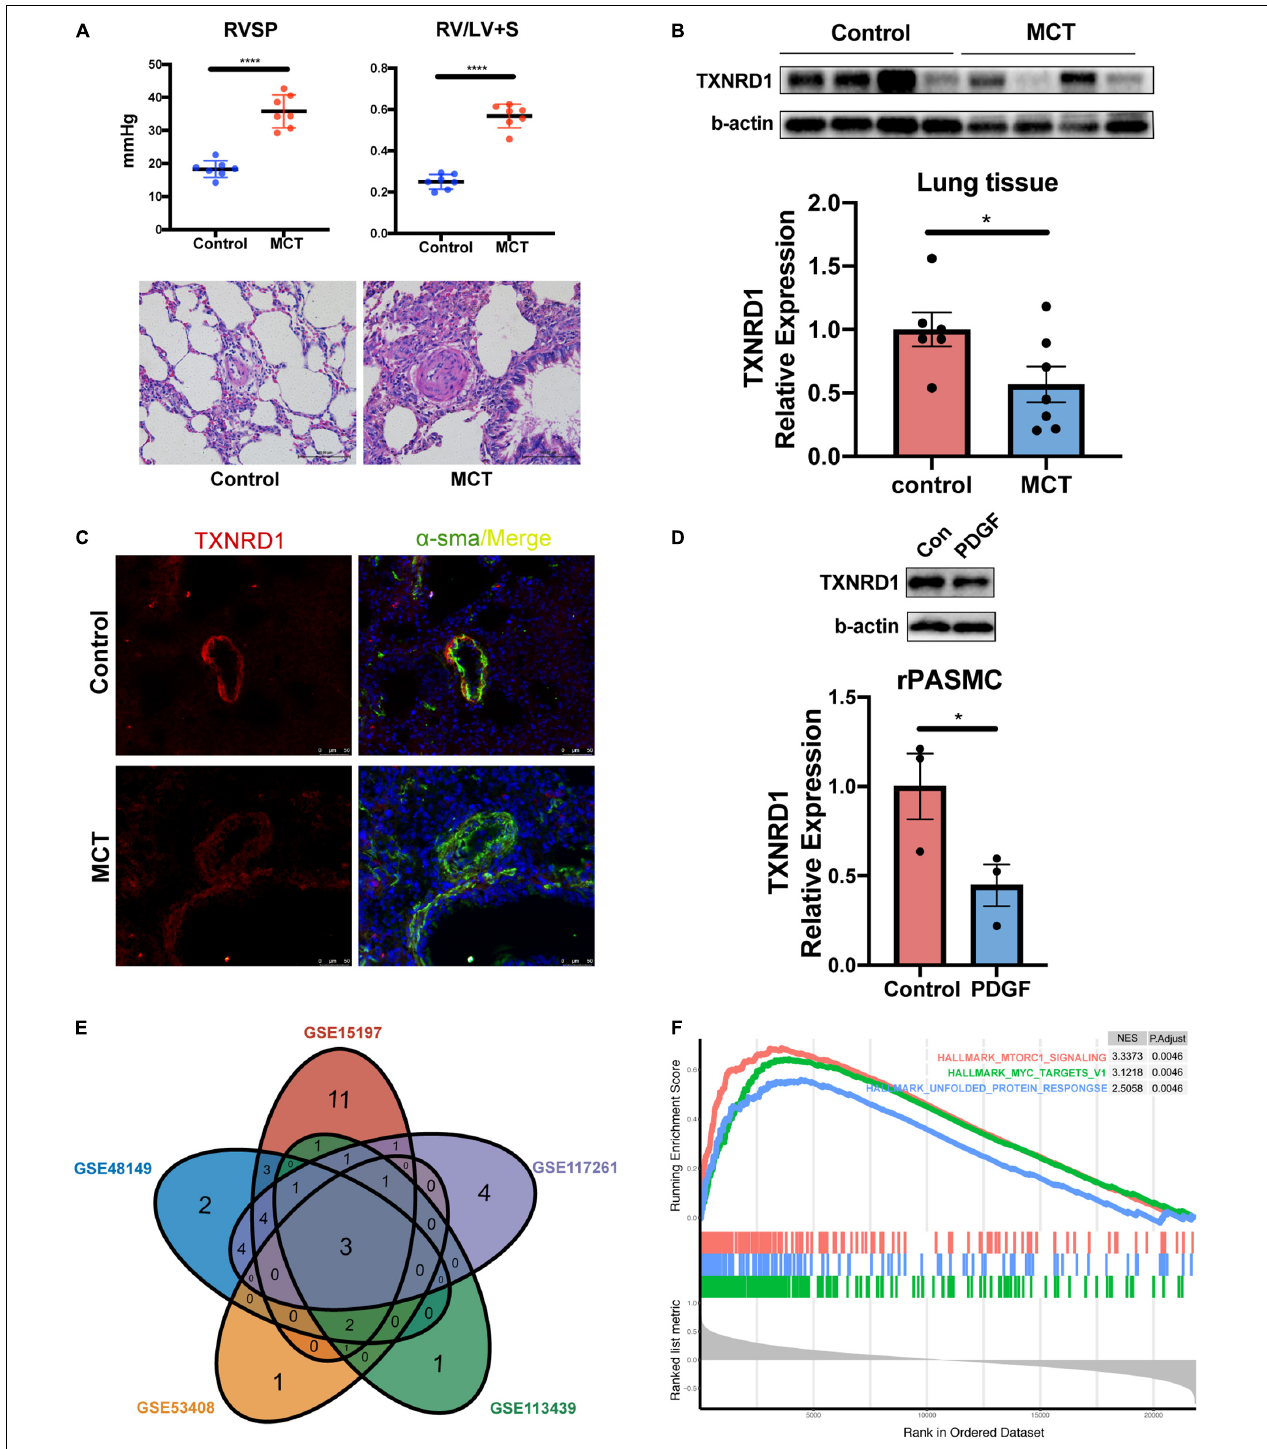
FIGURE 6 | In vitro and in vivo experimental validation and GSEA analysis of TXNRD1. (A) The hemodynamic data and HE staining of lung tissue in animal experiments. (B) Representative Western blots and quantification of TXNRD1 and β -actin in the lungs of monocrotaline treated rats and controls ( n = 7 each, * P < 0.05), data represent the mean ± SEM and Student t -test was used to compare two groups. (C) Immunofluorescence images of lung distal PA from MCT rats and controls. (D) Representative Western blots and quantification of TXNRD1 levels in rat PASMCs under PDGF-BB stimulation (30 ng/ml) normalized to a β -actin internal control ( n = 3 each,* P < 0.05). (E) Venn diagram of GSEA terms among five datasets based on correlation analysis of TXNRD1. (F) The overlapping three GSEA terms correlated with TXNRD1. **** P < 0.0001.